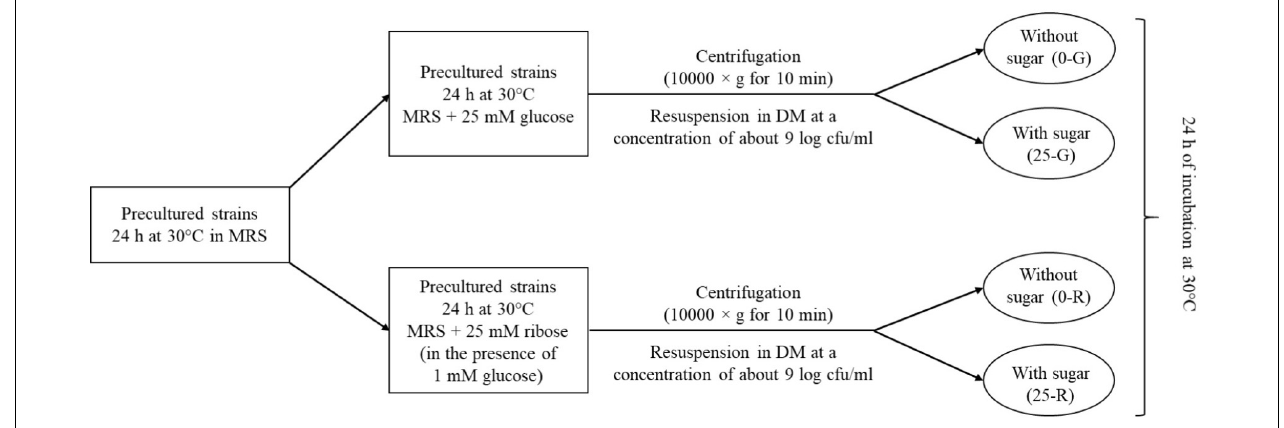
FIGURE 1 | Experimental plan for defined medium (DM)